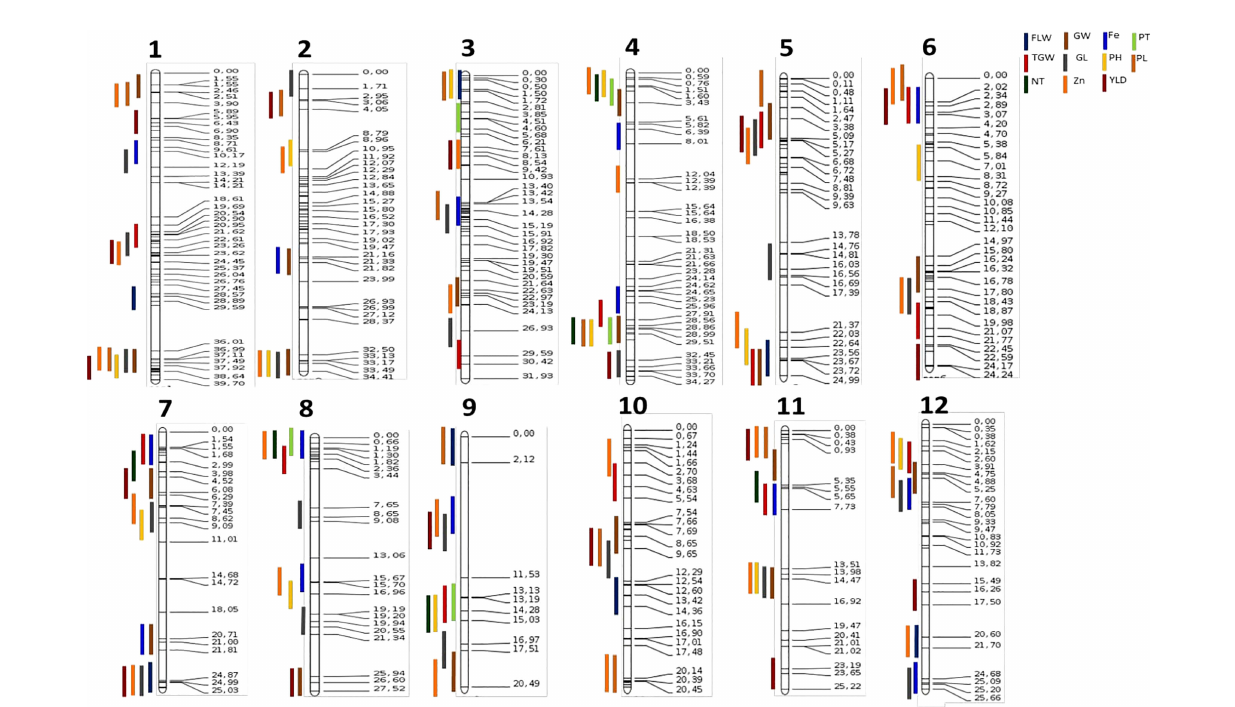
FIGURE 2 Consensus map of QTL detected for various traits. Vertical colored lines on the left represent different QTL while values on the horizontal lines at the right side show the position of the markers on the chromosomes; numbers below the fi gure indicate the corresponding